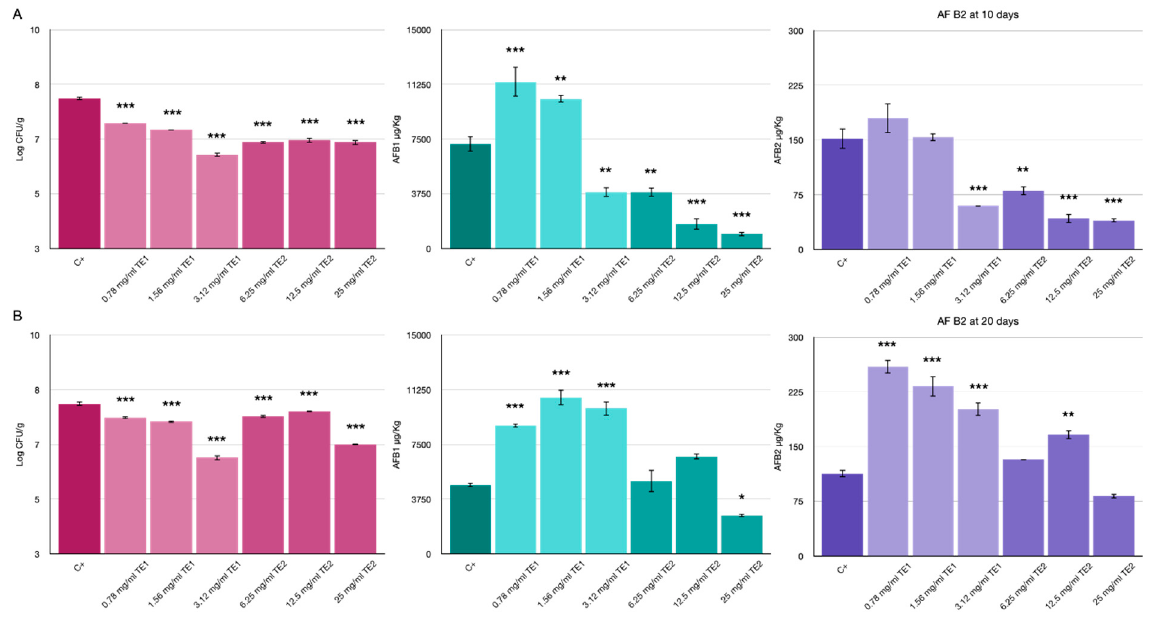
Figure 8. Effects of TE1 and TE2 on the growth of Aspergillus flavus in maize. Results expressed as microbiological count (log10 CFU/g) and AFs concentration detected (µg/Kg) at 10 days ( A ) and 20 days ( B ). Statistically significant differences for each treatment are indicated by * p < 0.05, ** p < 0.01, *** p < 0.001. Results are expressed as mean ± standard error.